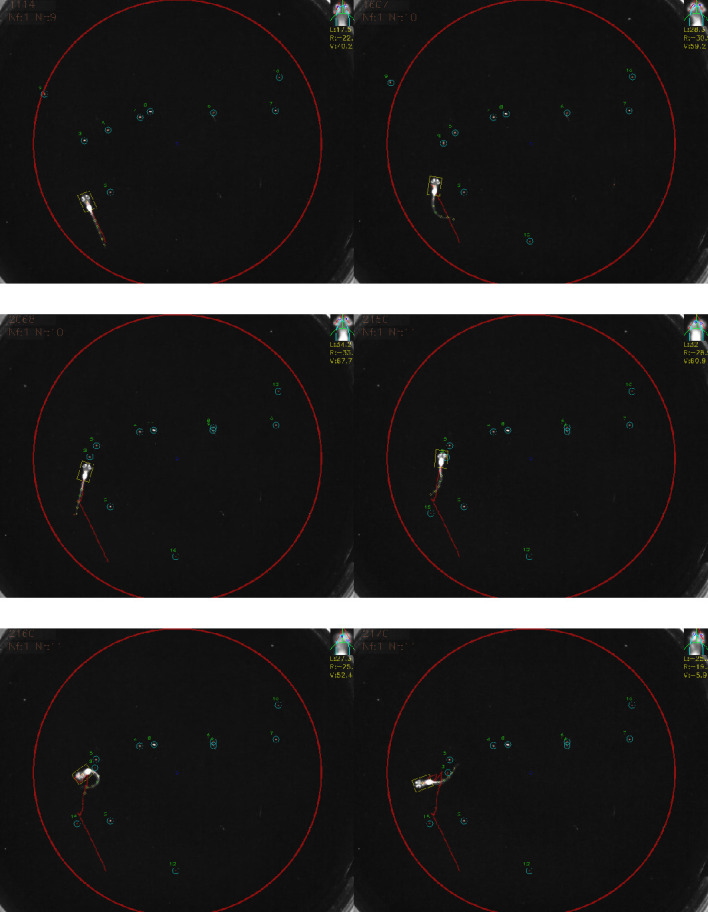
Example frames from a hunting sequence being tracked via our software showing initial detection of prey, turn to prey, approach and capture.The eye vergence angle is detected and shown at the top right of the screen.